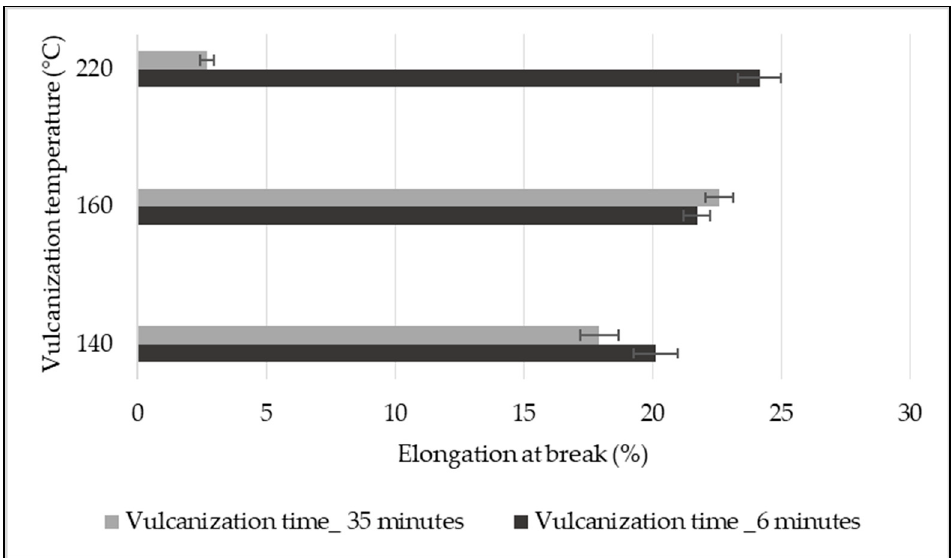
Figure 12. Effect of vulcanization conditions on the percentage elongation of the conveyor belt.